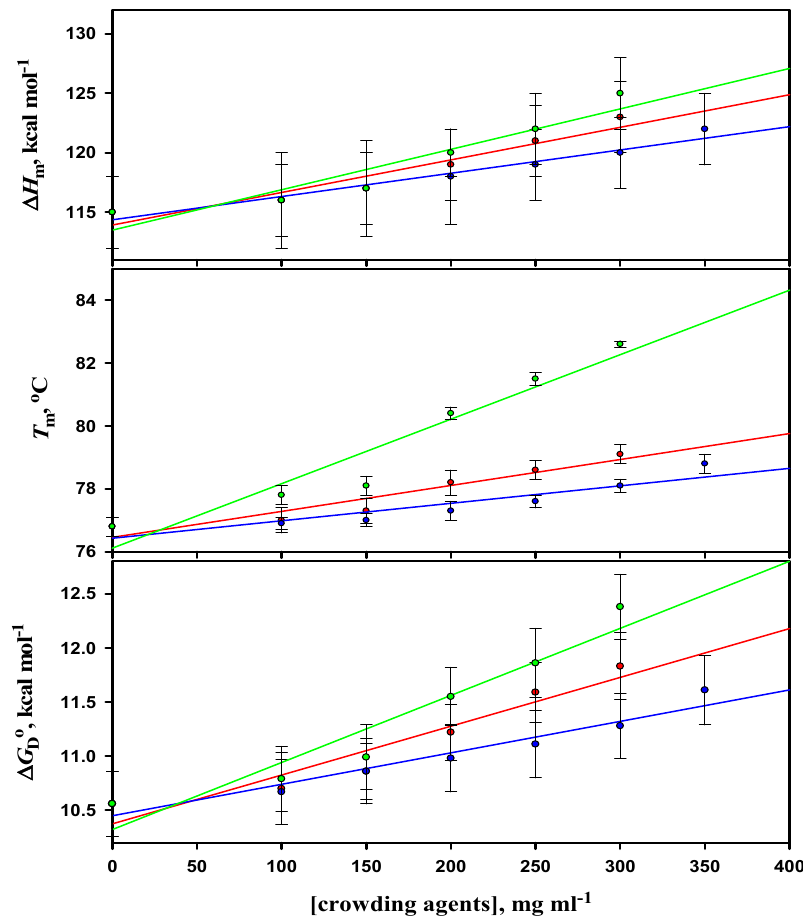
Figure 4. Plots of thermodynamic parameters ( T m , Δ H m , and Δ G D °) associated with the thermal unfolding of lysozyme versus concentration of ficoll 70 (blue line), dextran 70 (red line), and dextran 40 (green line) at pH 4.0. The results for ficoll 70 and dextran 70 were taken from our previous published work.